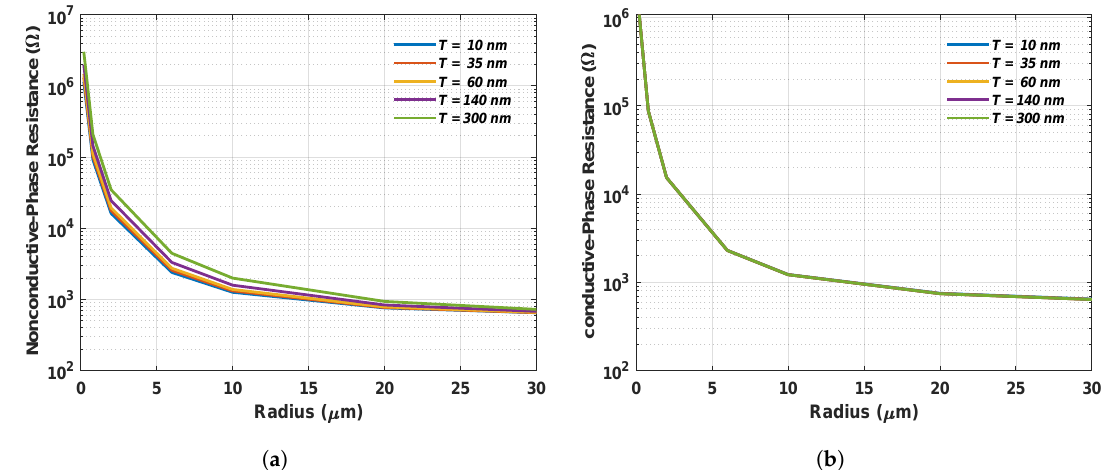
Figure 13. VO 2 resistance during ( a ) the nonconductive phase and ( b ) during the conductive phase at different